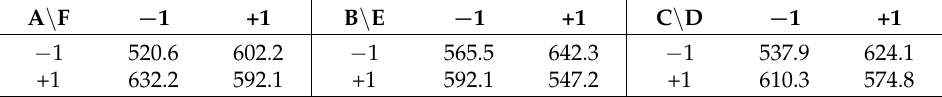
Table 12. Analysis of the interactions AF + BE + CD versus flexural strength in Region I. Figure 5. Representation of the standardized effects on a normal probability plot versus the unnotched Charpy test: ( a ) Region I and ( b ) Region II.